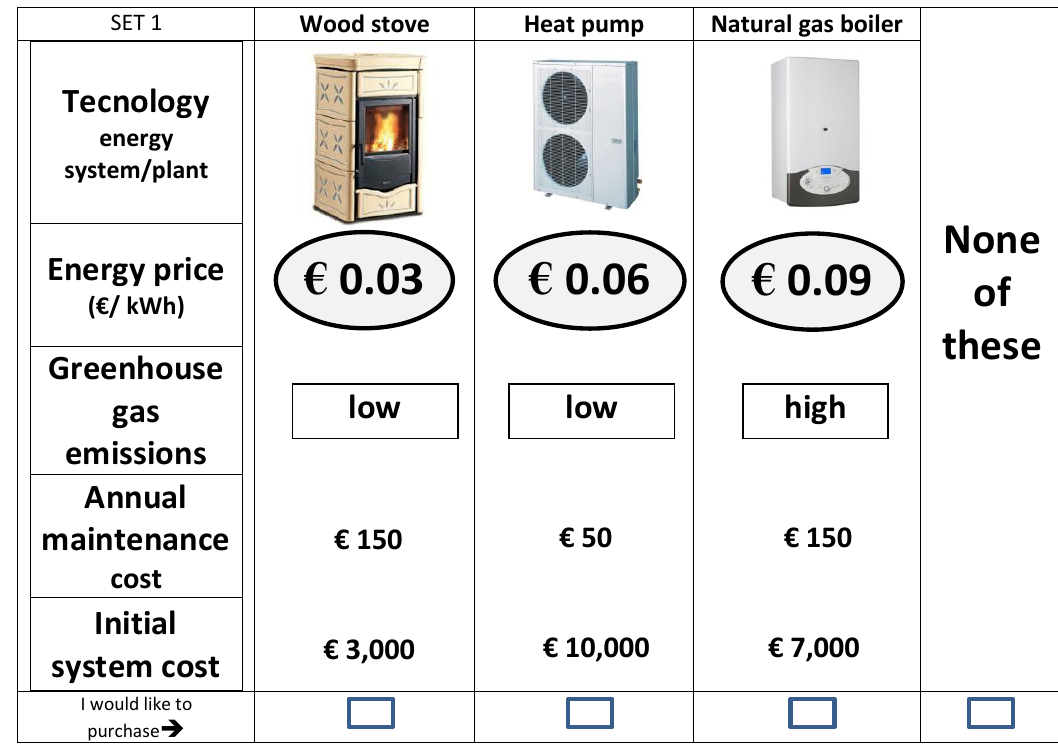
Figure 1. One of the DCE choice cards presented to respondents.